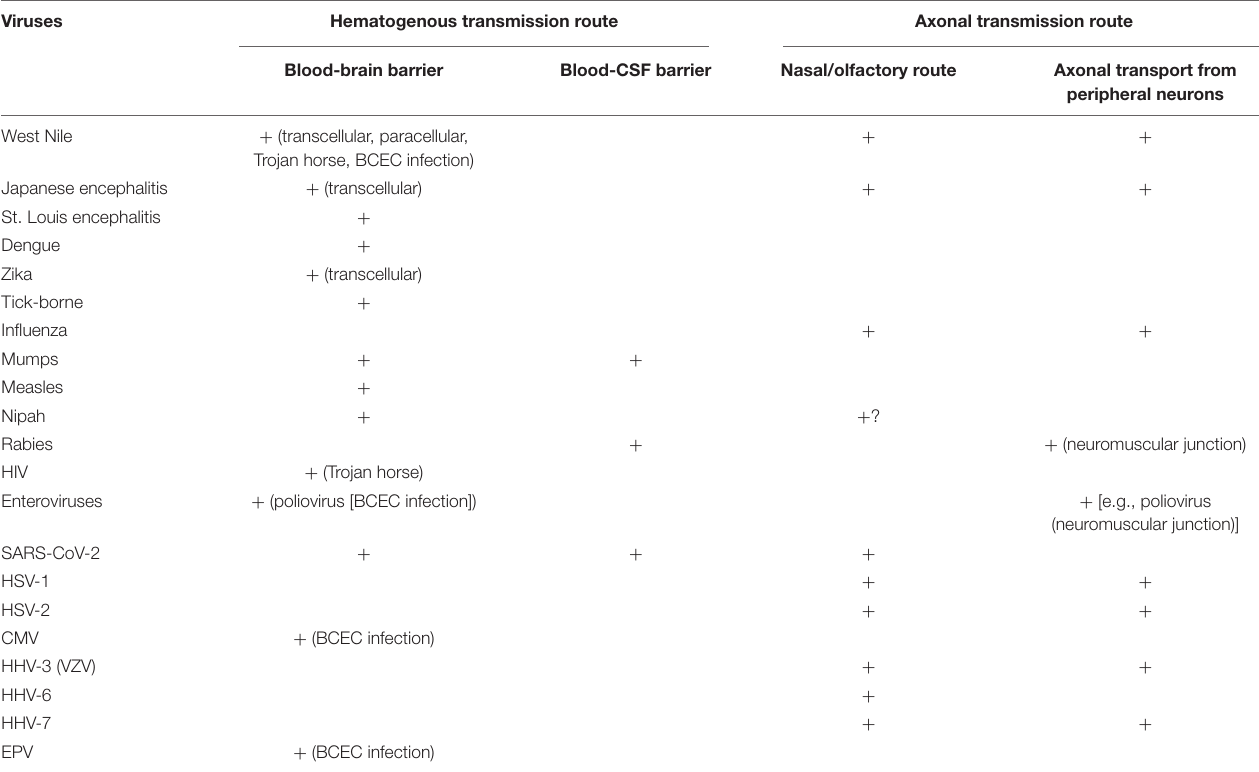
TABLE 2 | Mechanisms of neuroinvasion by neurotropic